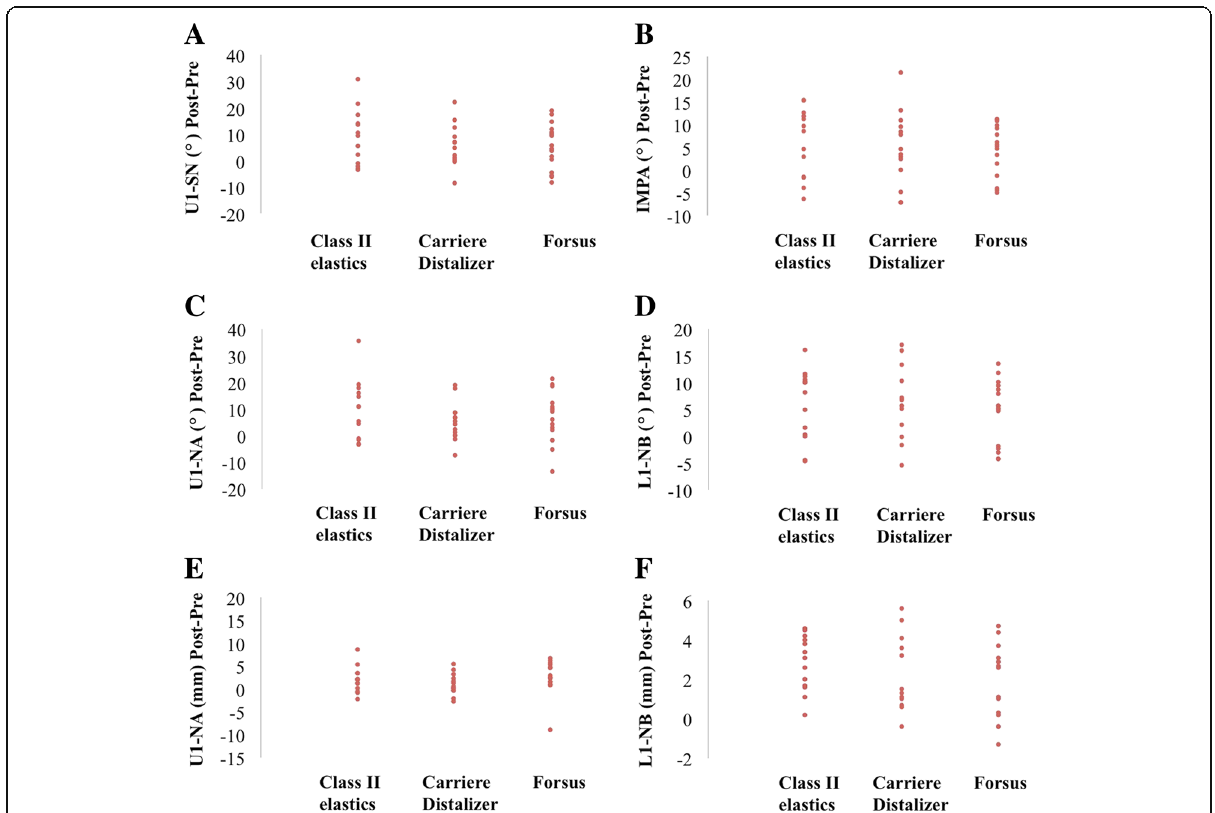
Fig. 7 a – f Pre- and post-treatment changes in maxillary and mandibular dental measurements. * P < 0.05, ** P < 0.01, *** P <